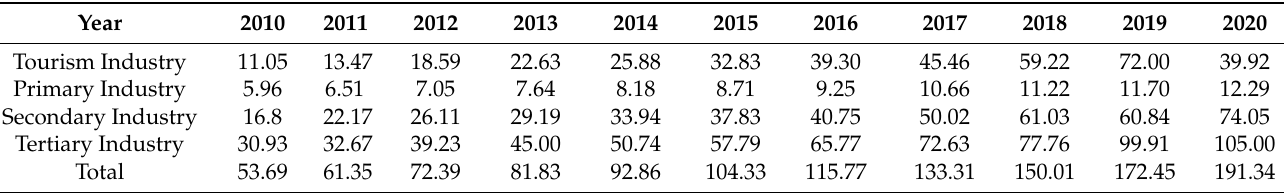
Table 2. Sub-county (district) population data of Nyingchi from 2010 to 2020 (unit: person). County